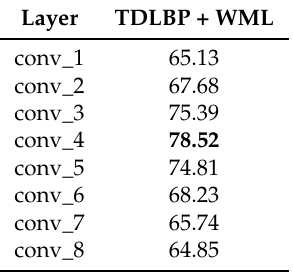
Table 8. The performance of TDLBP + WML in different convolutional